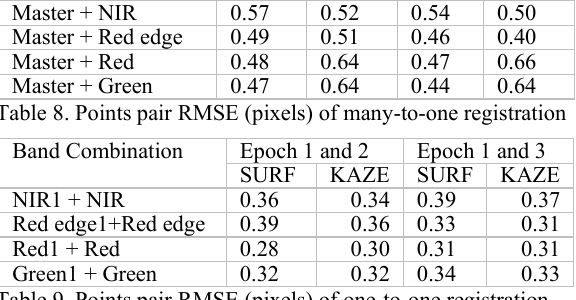
Table 9. Points pair RMSE (pixels) of one-to-one registration The one-to-one registration approach yields better results than many-to-one approach. The many-to-one approach recorded an average RMSE of 0.5 against the one-to-one approach of 0.36 across all band combinations. The similarity in spectral properties per band combination in one-to-one approach is one of the possible reasons as to why band pairs are better aligned.